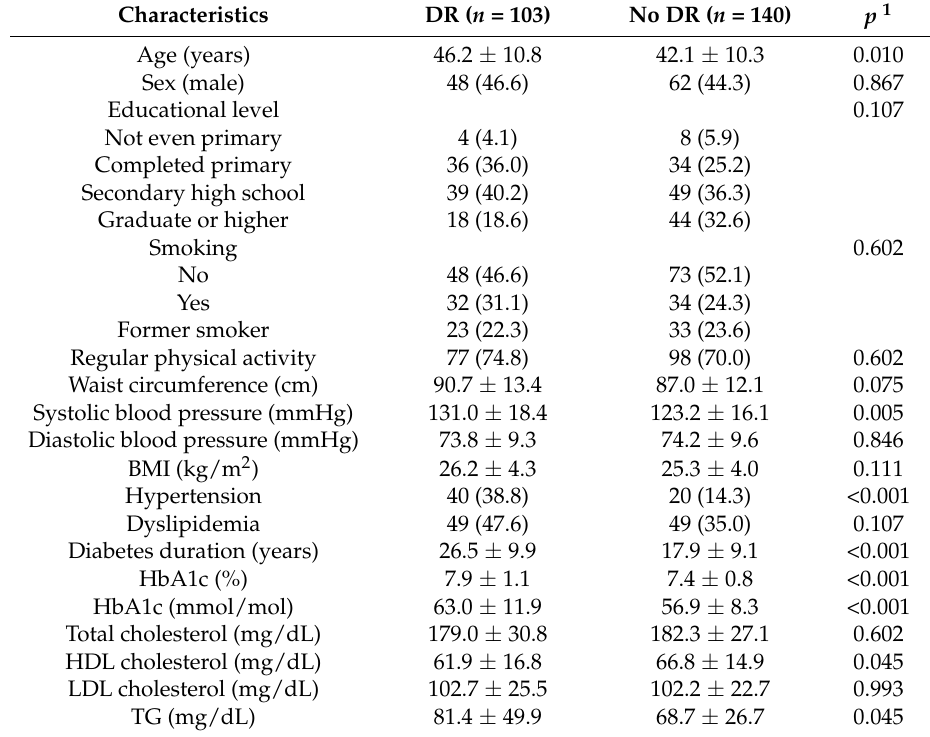
Table 1. Clinical characteristics of participants according to diabetic retinopathy